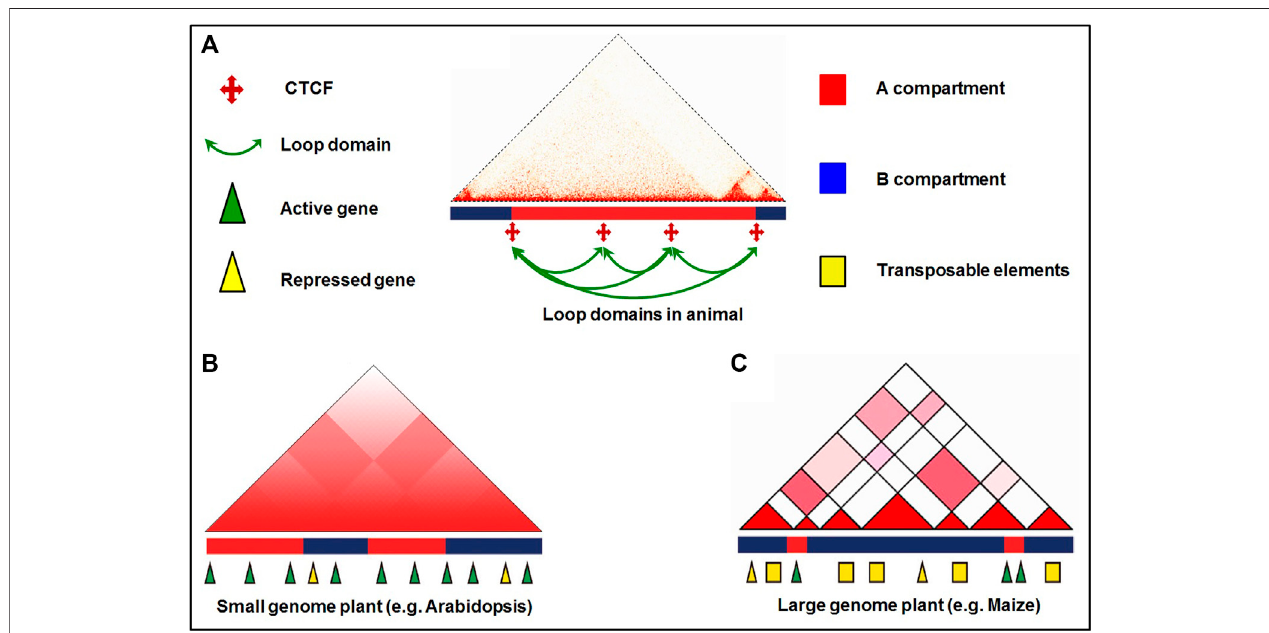
FIGURE 5 | Comparison of 3D chromatin organization of animals and plants. (A) Loop domain in the mammalian genome. CTCT loops are formed at the domain corner, and these domains are located within a compartment. Small adjacent loop domains form larger domains having nested structures. The dynamics of a loop domain is associated with changes in CTCF binding. (B) In Arabidopsis, chromosome arms are partitioned into loose structural domains (LSDs) and compacted structural domains (CSDs) which are comparable to the local A/B compartments rather than the mammalian TAD and the global compartment domain of large- genome plant. (C) Compartment domains in the large-genome plants often overlap with local compartments having active genes located inside the domain associated with the A compartment. Transposable elements and repressed genes are located in the domain with the B compartment.